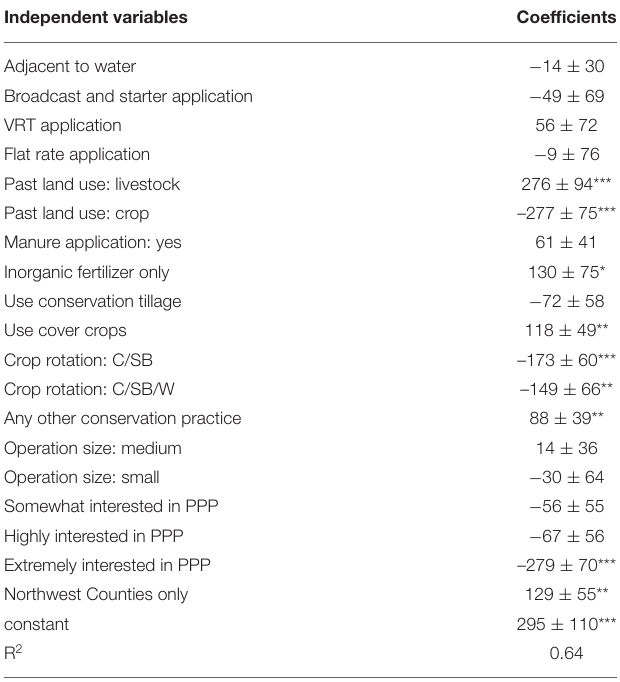
TABLE 3 | Factors associated with max soil test phosphorus concentrations (mg STP kg − 1 soil) on each field. Independent